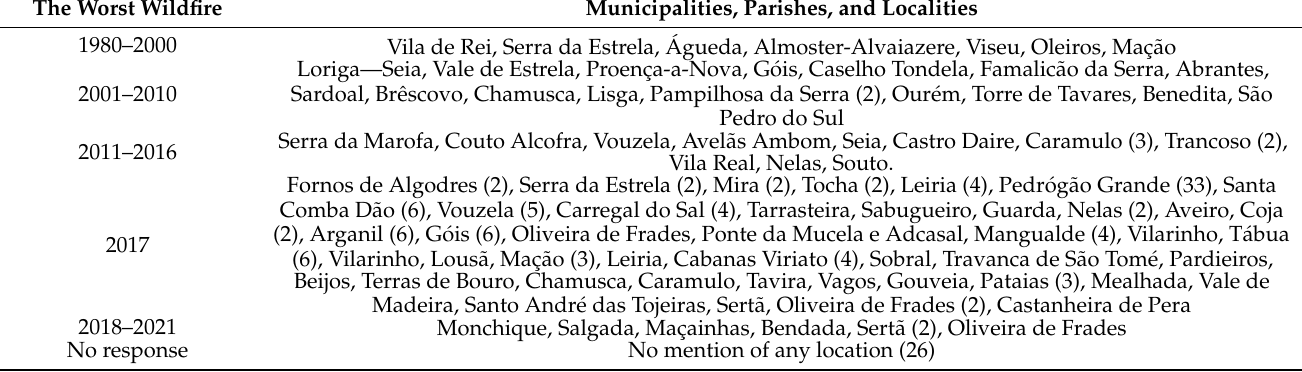
Table 6. Municipalities and localities where the worst wildfires were reported by respondents ( n =